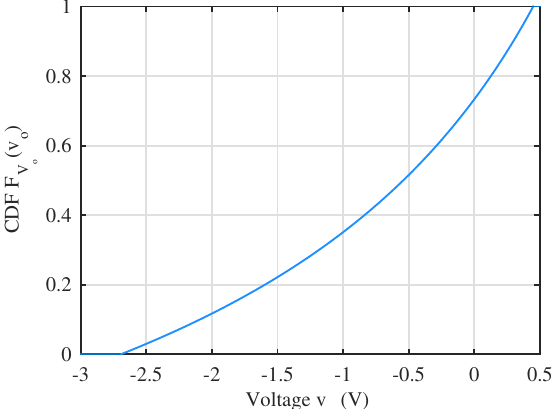
( v o ) when L is a uniform, ( a , b ) , continuous o H, b = 3 H. 4 4